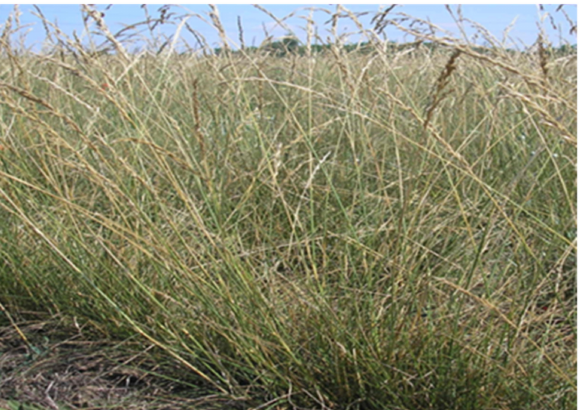
Figure 3. Tall fescue ( Festuca arundinacea Schreb) Variety Albena. Author’s photos of Prof. A.